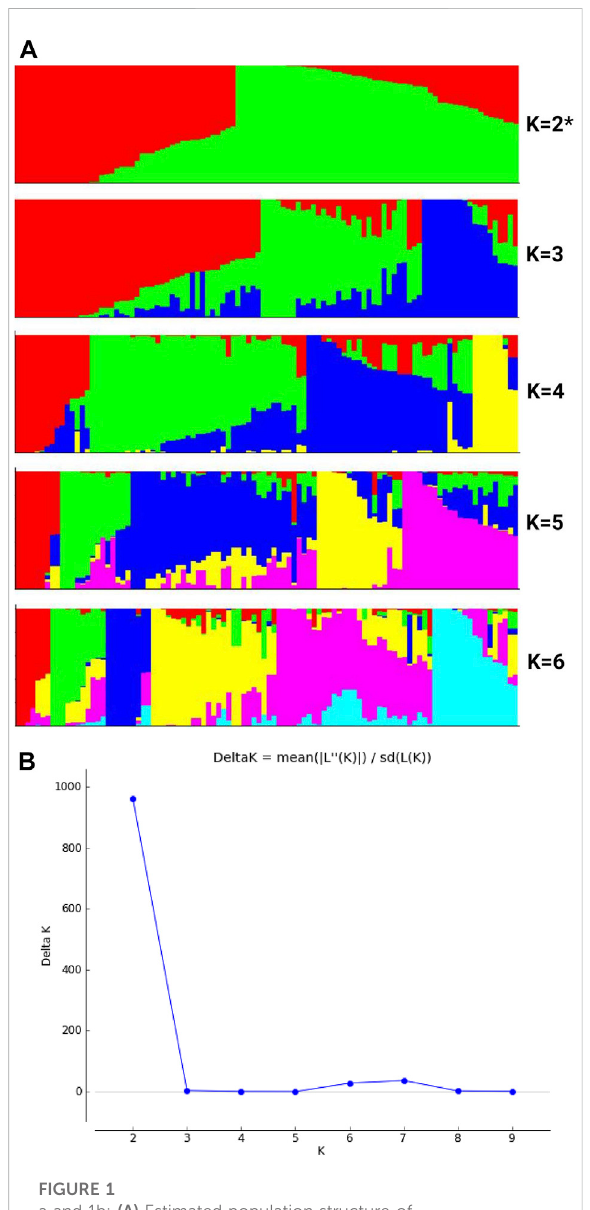
FIGURE 1 a and 1b: (A) Estimated population structure of 100 accessions of Cucurbita maxima on K = 6. Accessions in red areclustered intopop1andthoseingreenareclusteredintopop2 . (B) Delta K ( Δ K ) for different numbers of subpopulations ( K